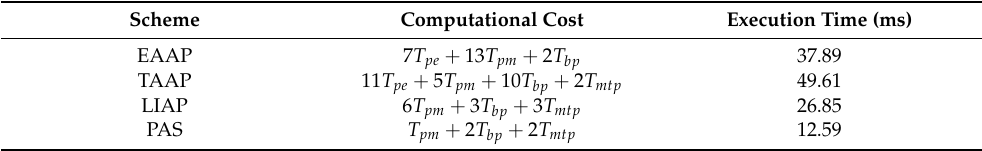
Table 4. The computational cost of each